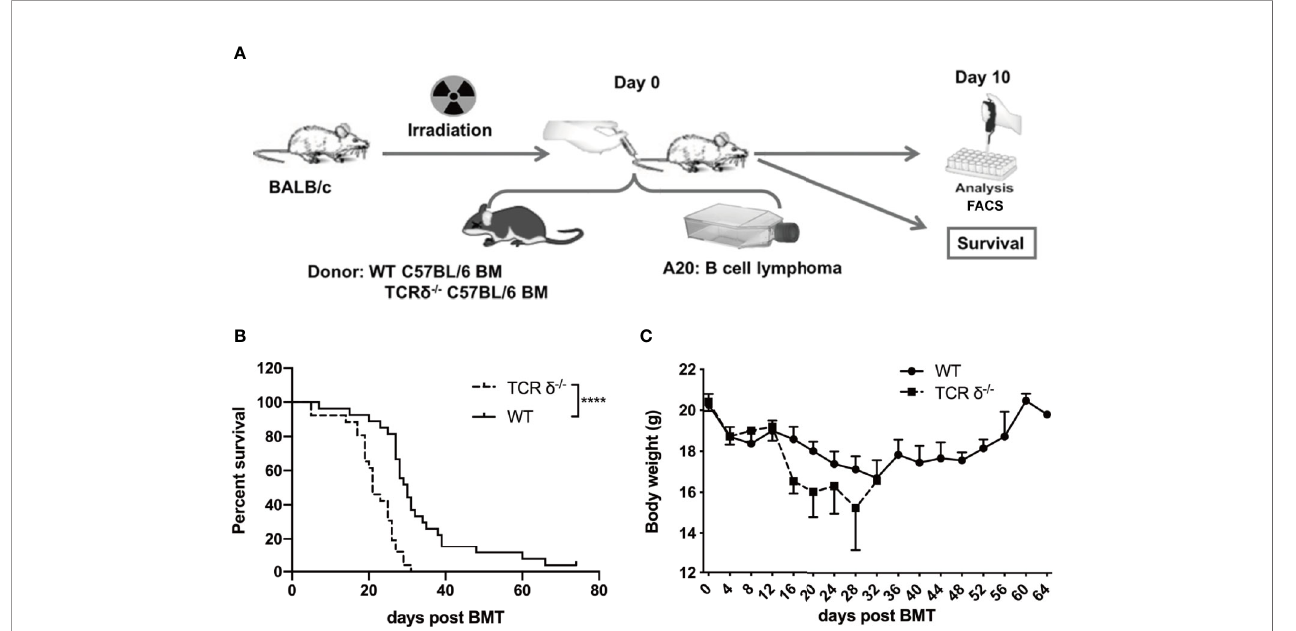
FIGURE 1 | The GVL effect of donor-derived gd T cells in allo-HSCT. (A) The experimental design of murine GVL model. Recipient mice (BALB/c) were lethally irradiated and received A20 lymphoma cells (1 × 10 6 cells/mouse, iv. ) plus BMCs (5 × 10 6 cells/mouse, iv. ) from WT or TCR d ‐ /- mice. The phenotypes of immune cells from spleens and livers of recipient mice were examined on day 10 post allo-HSCT. The survival (B) and the body weight (C) of recipients were observed and measured (n = 26 – 27 mice per group). Results shown (B, C) were pooled from 3 independent experiments. The graph (C) displays mean ± SEM. Signi fi cance was determined by log-rank (Mantel-Cox) survival test (B) and unpaired 2-tailed Student ’ s t tests (C) . **** p <